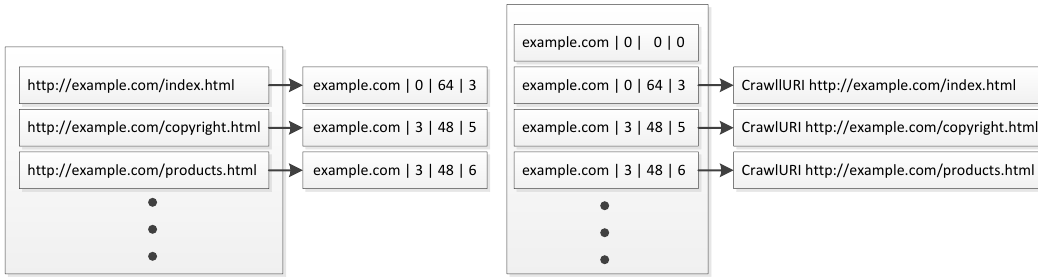
Figure 6. Example of Adaptive Heritrix frontier data structures and URL